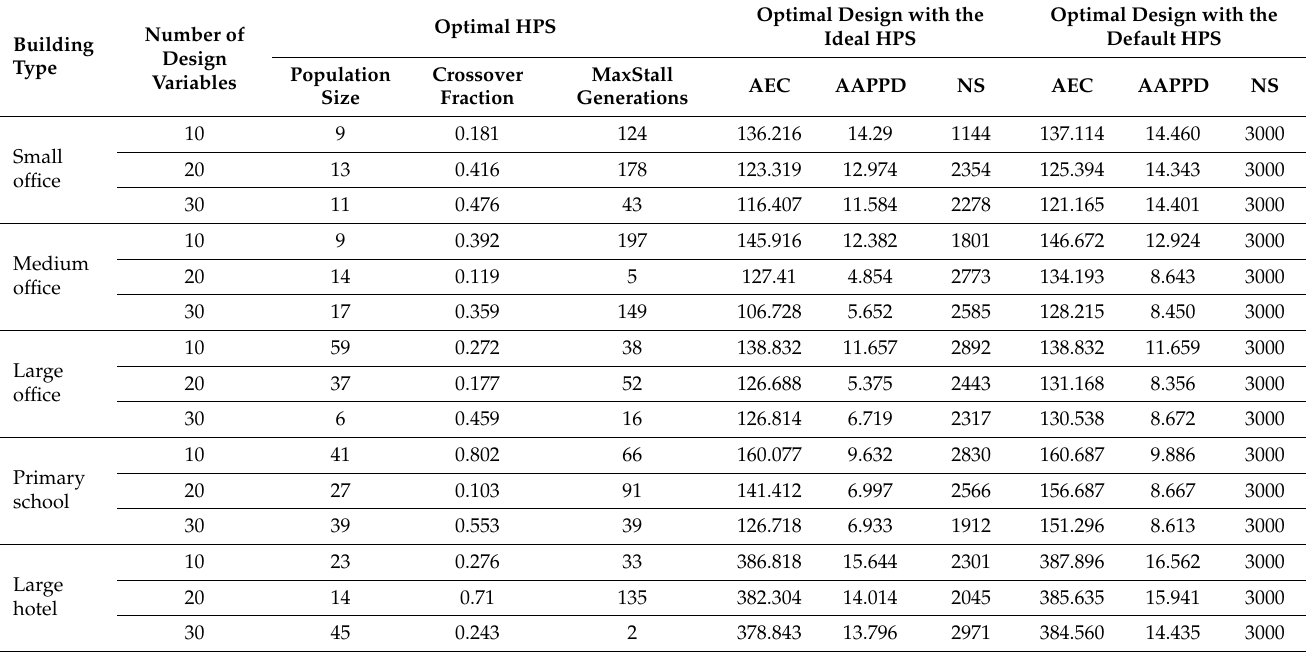
Table 8. Optimal HPSs for the